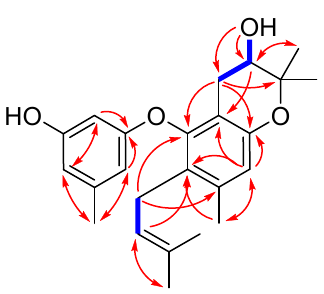
Figure 2. Key COSY (bold blue lines) and HMBC (red arrows) correlations for compound 1 .